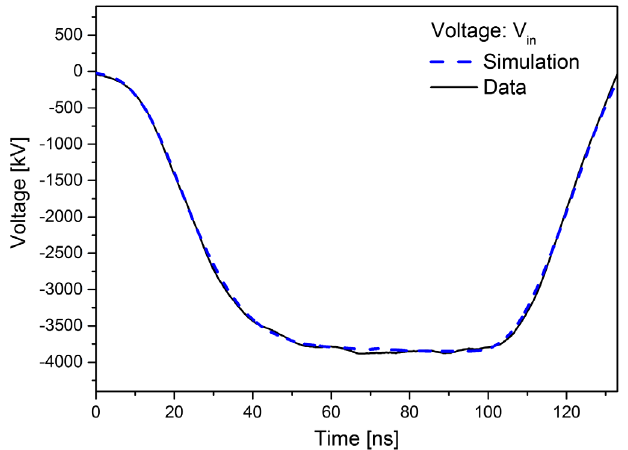
FIG. 1. Geometry used for simulating the beam dynamics inside an injector of an induction accelerator. BPM (for beam positioning monitor) indicates the location of the current sensors. The inset is a zoom in the diode region.